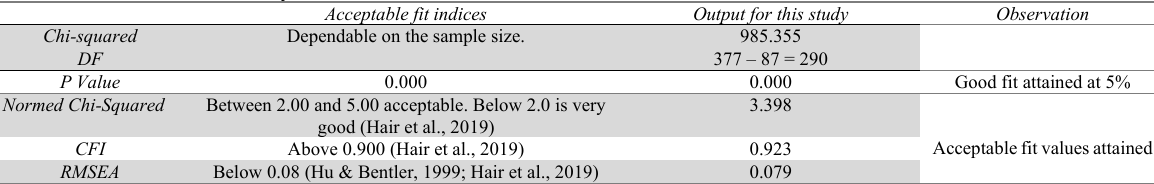
Fig. 2. Structural equation model to obtain the measures of mediation by Customer Satisfaction The overall fit of the modified structural model from the AMOS output obtained. The results indicate an excellent fi t of the structural model. The fit indexes are tabulated in Table 5 provided below: Fit Index obtained for this